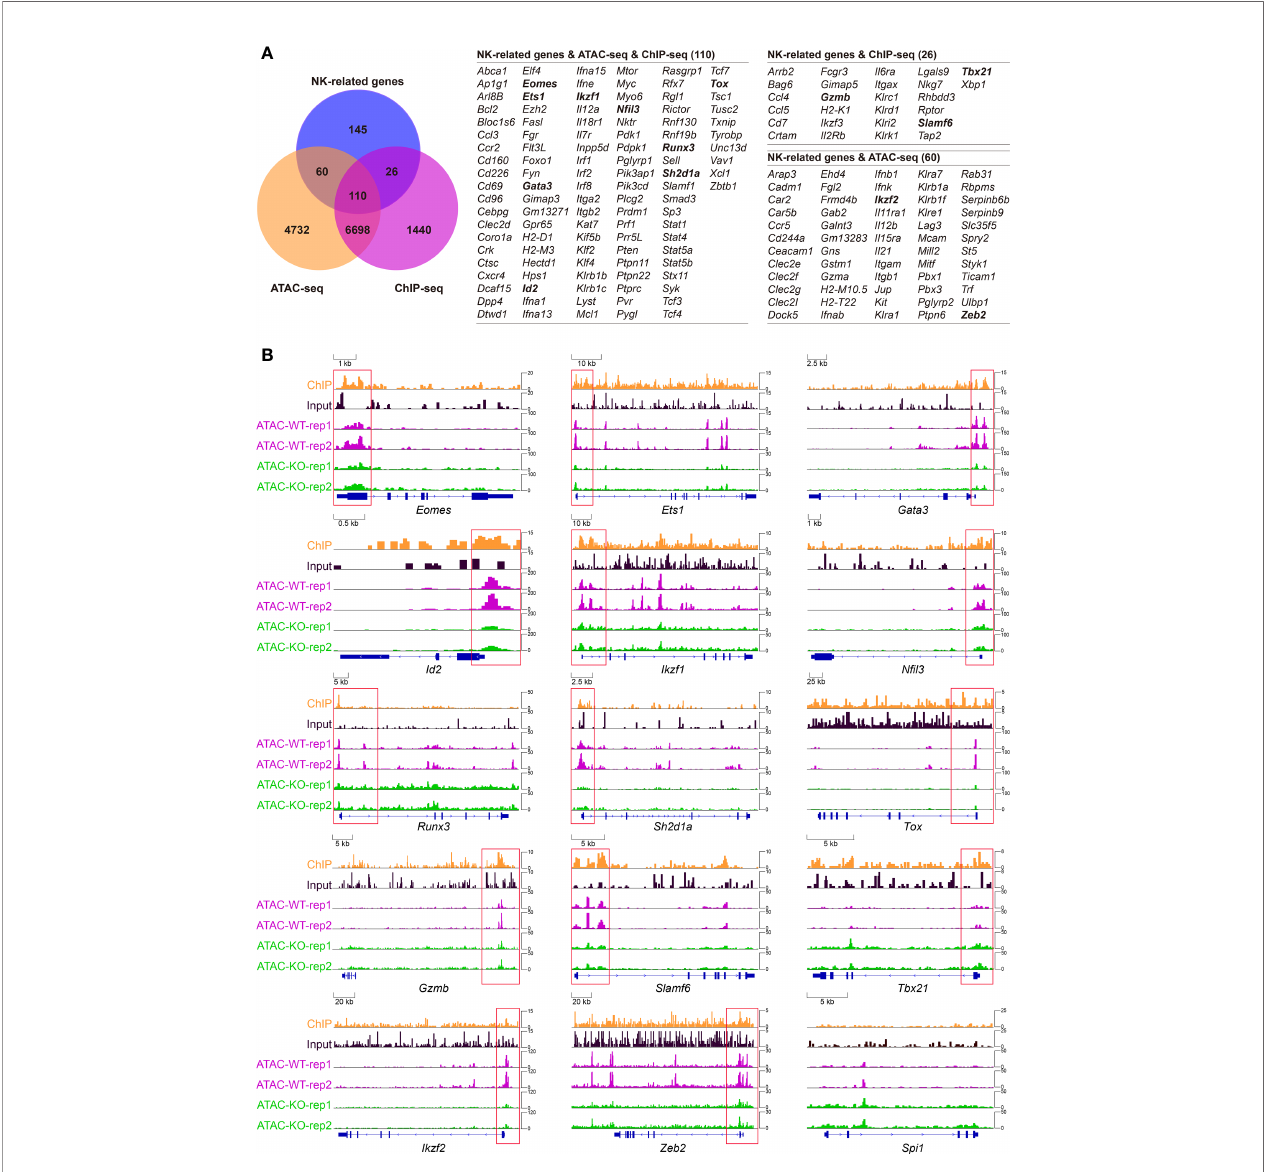
FIGURE 6 | Combined analysis of high-throughput data showing Tcf1 associated NK regulatory program. (A) Left: Venn diagram showing the relationship among NK signature genes, Tcf1-dependent chromatin accessibility (differential ATAC-seq signals, GSE99159) and Tcf1 binding (differential enrich peaks from ChIP-seq analysis, GSE73239). The interested genes are shown in bold formatting. (B) The Integrated Genome Viewer (IGV) screenshots exhibiting ChIP-seq and ATAC-seq pro fi les in Eomes , Ets1 , Gata3 , Id2 , Ikzf1 , N fi l3 , RunX3 , Sh2d1a , Slamf6 , Tox , Tbx21 , Ikzf2 , Zeb2 and Spi1